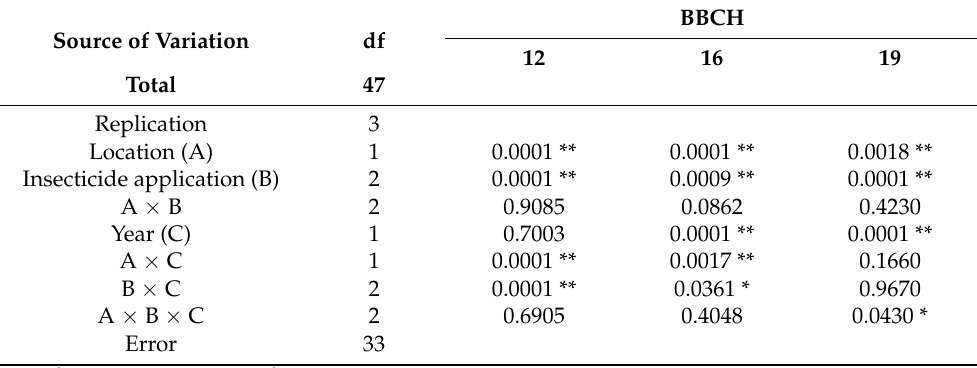
Table 6. Factorial analysis (ANOVA) of the percent of damages (according to Towsend-Heuberger) caused by sugar beet weevil in different developmental stages of sugar beet plants. Source of Variation df